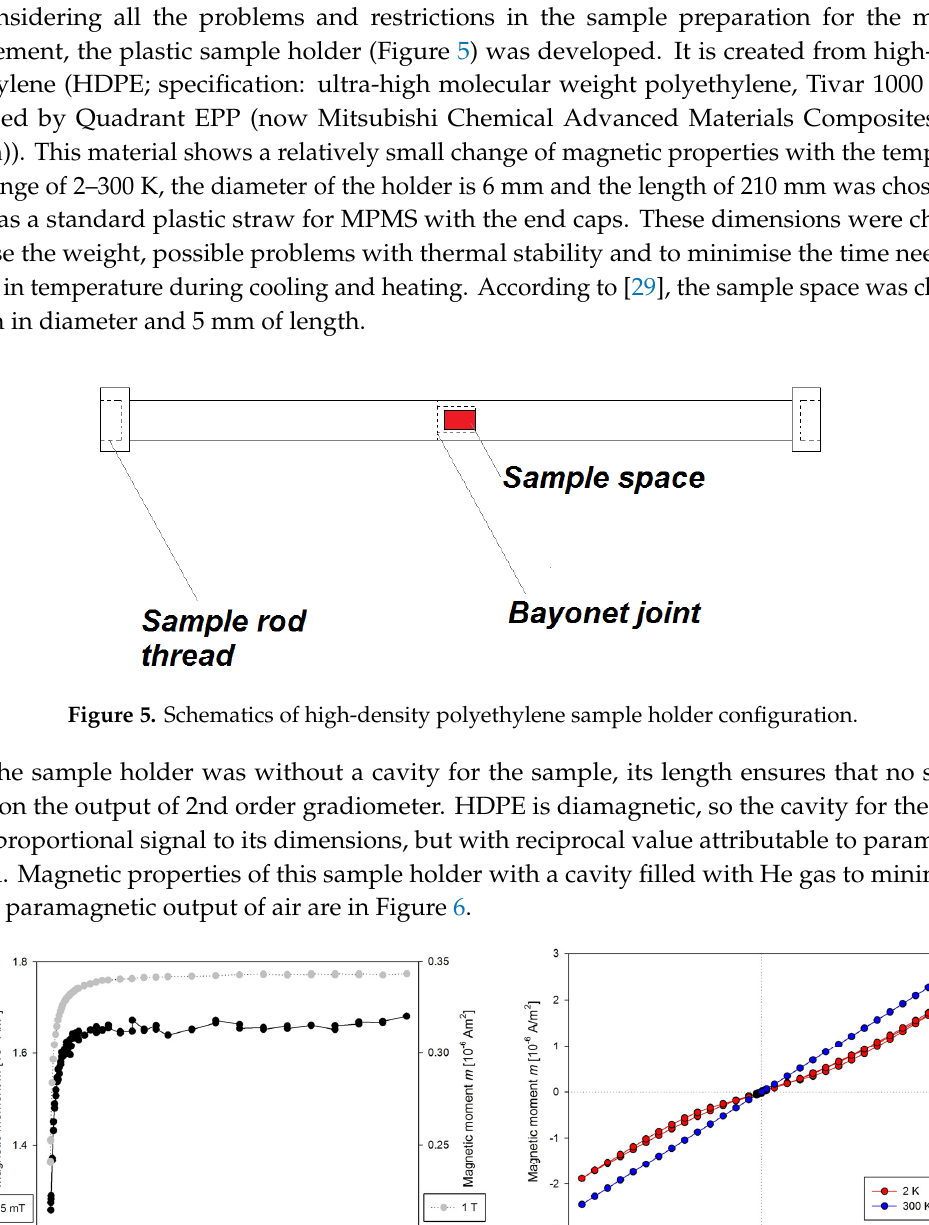
Figure 4. ( a ) Temperature dependence of the mass magnetisation of the same sample as in Figure 3, ( b ) M ( H ) dependence of the WKY rat heart at 300 K, ( c ) M ( H ) dependence of WKY rat liver at 300 K.